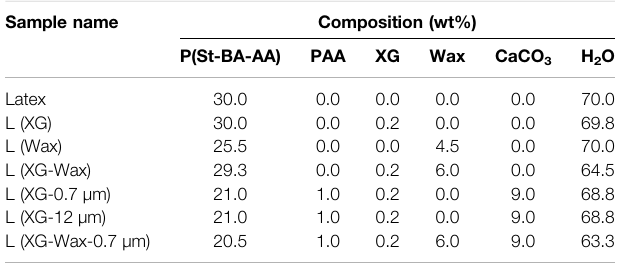
TABLE 1 | Sample nomenclature and percentage weight of each component for wet formulated mixtures.